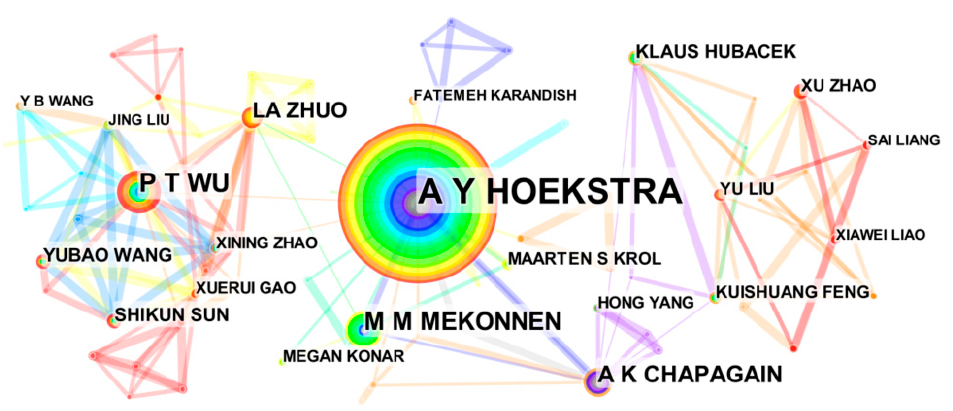
Figure 5. Collaborative network among authors.